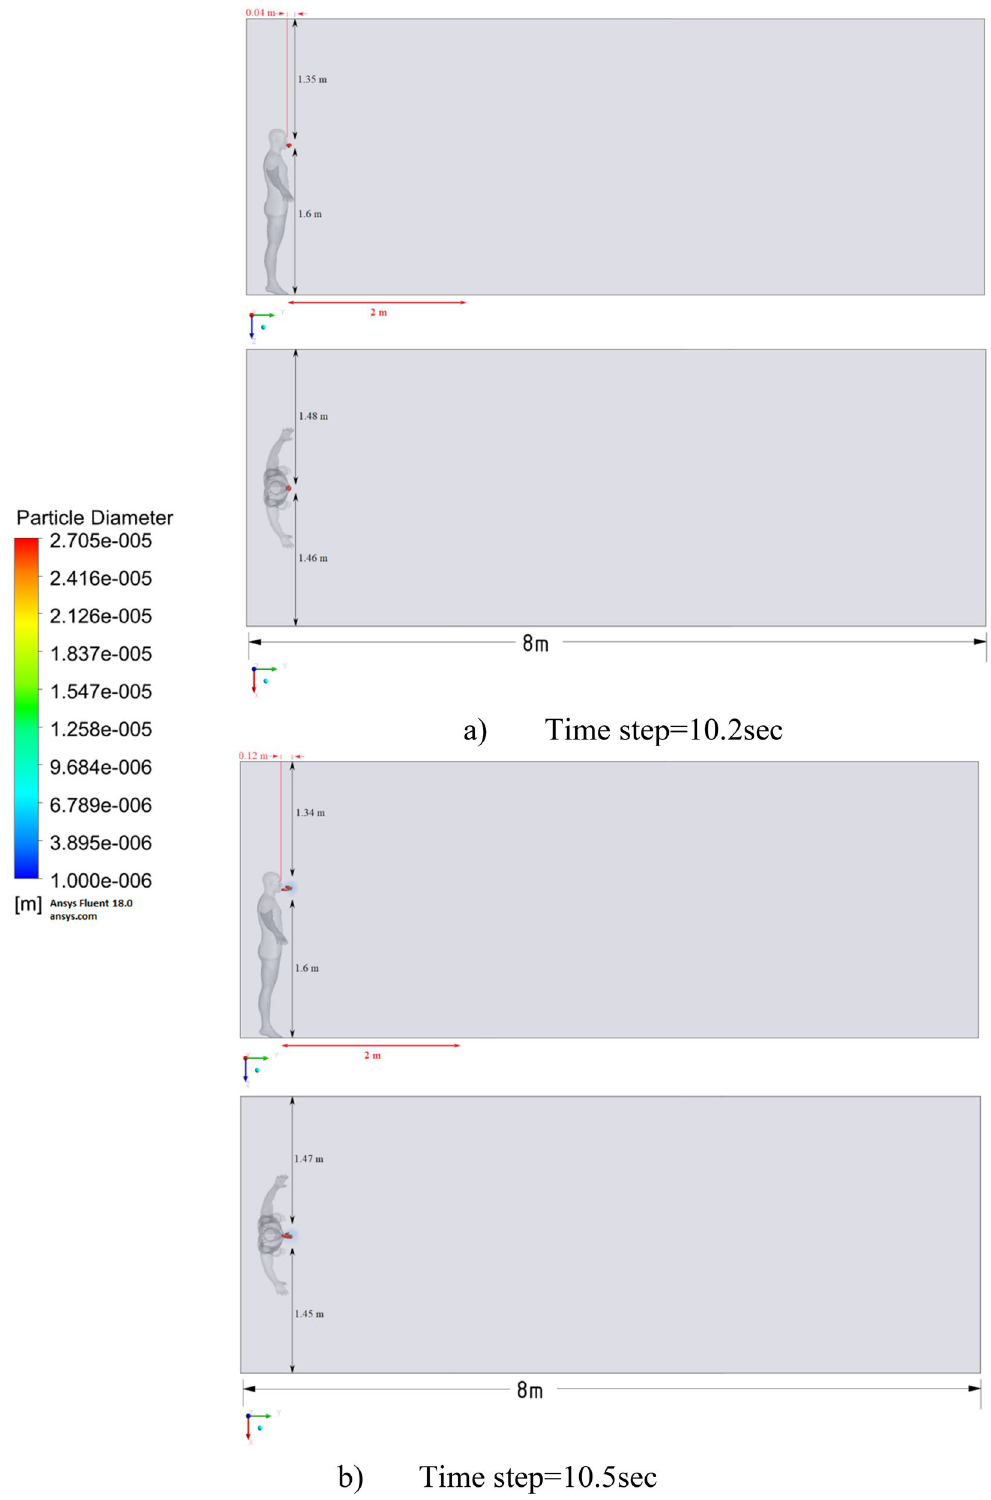
Figure 21. Distribution of the particles for cough = 1 m/s and ventilation = 1